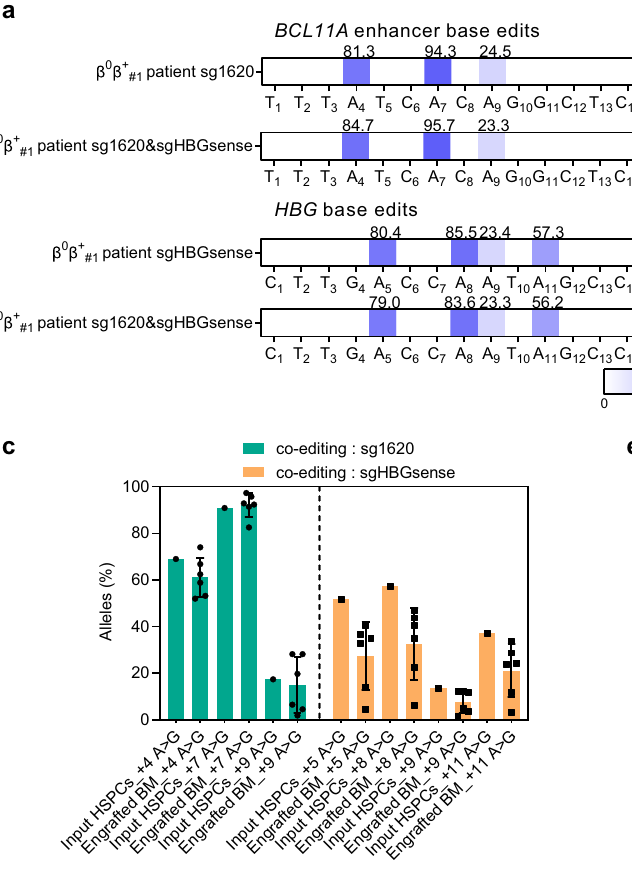
infusion. Data are plotted as mean±sd. n =5 mice for mock and n =6 mice for edited group. e Percentage of engrafted human B cells, myeloid cells and CD19 − CD33 − cells 16 weeks after transplantation (donor cells from β 0 β + #1 patient). Data were presented as mean±sd, n =5 mice for mock and n =6 mice for edited group. f β -like globin expression analyzed by RT-qPCR normalized by α globin, measured from β 0 β + #1 patient donor BM chimerism 16 weeks after base edited HSPC infusion. Data are plotted as mean±sd and analyzed with the unpaired two- tailedStudent ’ s t test, p valueshavebeennotedonthecorrespondingcomparison. n =9 replicates for mock, and n =11 for edited